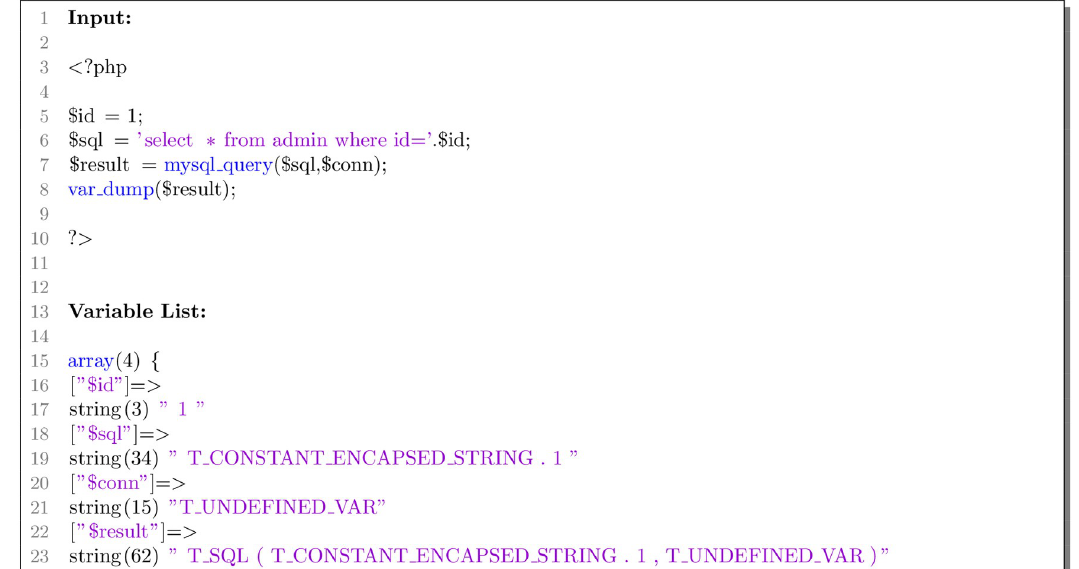
Fig 4. Example of variable